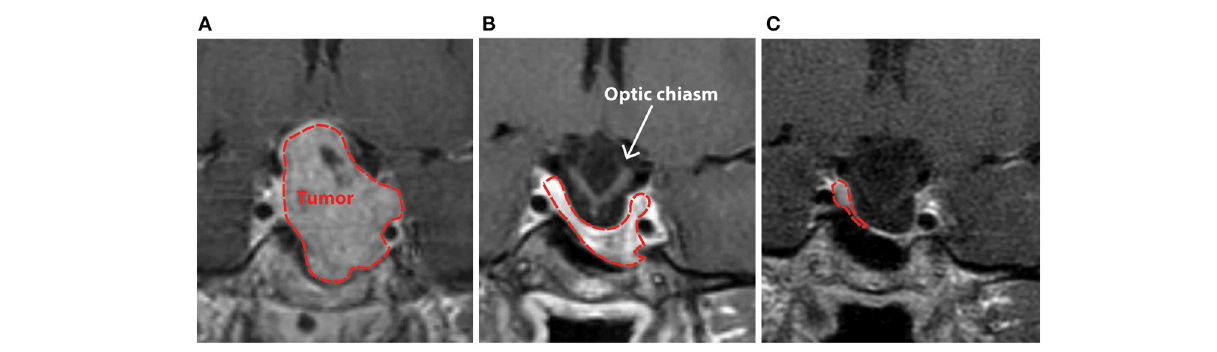
FIGURE 1 | Clinical T1-weighted MRI scan with contrast demonstrating patient AJ’s pituitary macroadenoma in 2009 prior to (A) , and after initiation of treatment with cabergoline (B) , with progressive herniation of the optic chiasm into an empty sella (C) that was present at the time of study enrollment in 2018. Initial imaging of the mass in 2009 (A) demonstrated significant contrast enhancement with expansion of the sella-turcica, asymptomatic extension of the tumor into the left cavernous sinus, and suprasellar extension with some deviation, but no outright compression of the optic chiasm. The normal pituitary gland and stalk were pushed to the right and